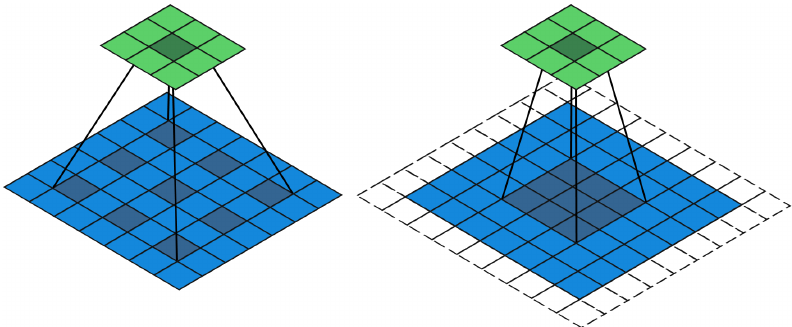
Figure 2. Dilated convolution ( left ) and conventional convolution ( right ).